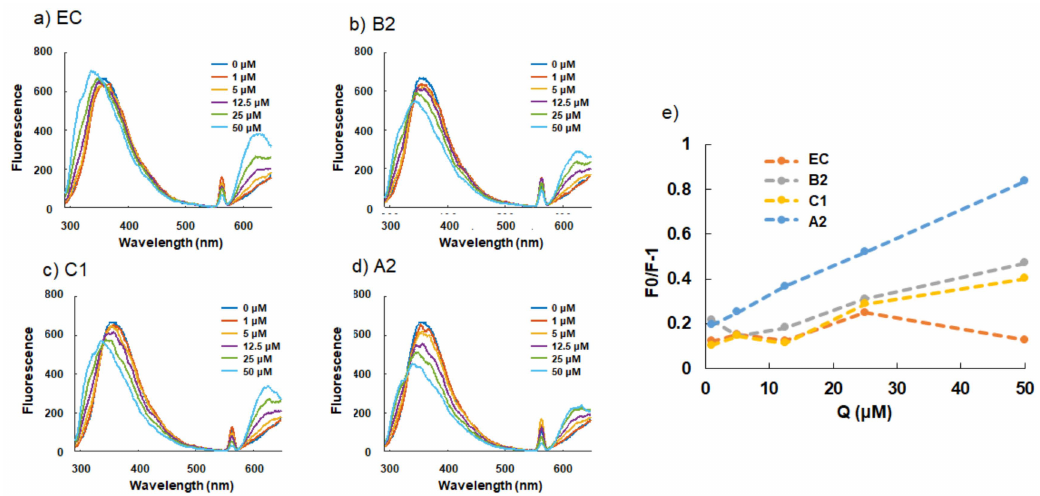
Figure 2. Emission spectra of BSA in the presence of di ff erent concentrations of EC ( a ), B2 ( b ), C1 ( c ), A2 ( d ) and Stern–Volmer plots ( e ). F and F 0 are the emission intensities in the presence and absence of EC, B2, C1 or A2, respectively, measured at the emission wavelength of 350 nm.